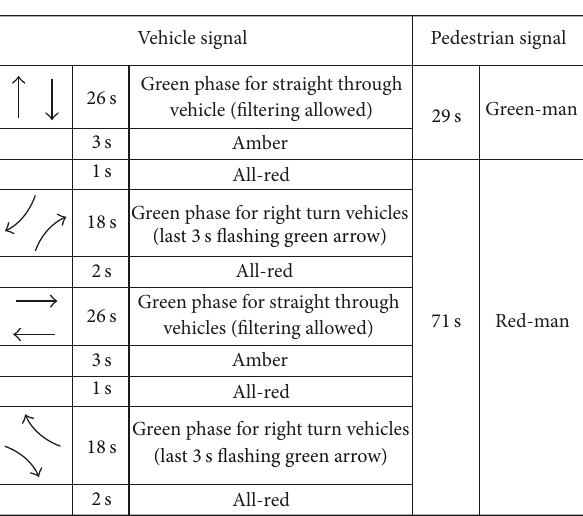
Figure 7: Signal timings of vehicle/pedestrian movements. It is found that the safety impact of GMCD is affected by traffic condition as well as different time duration within green-man signal